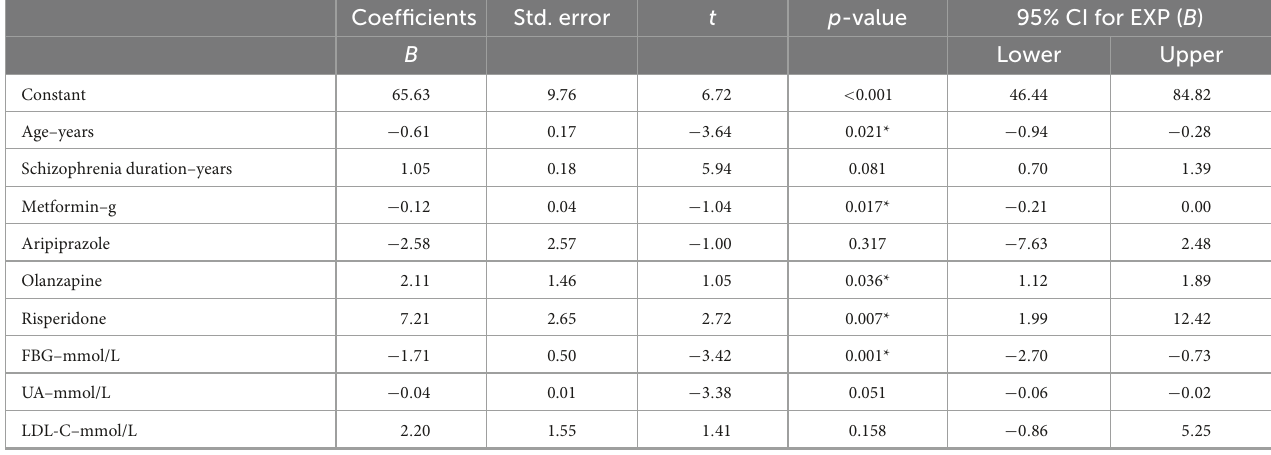
TABLE 3 Influencing factors of prolactin (PRL) levels in include patients with type 2 diabetes (T2DM): multiple linear regression model. Coefficients Std. error